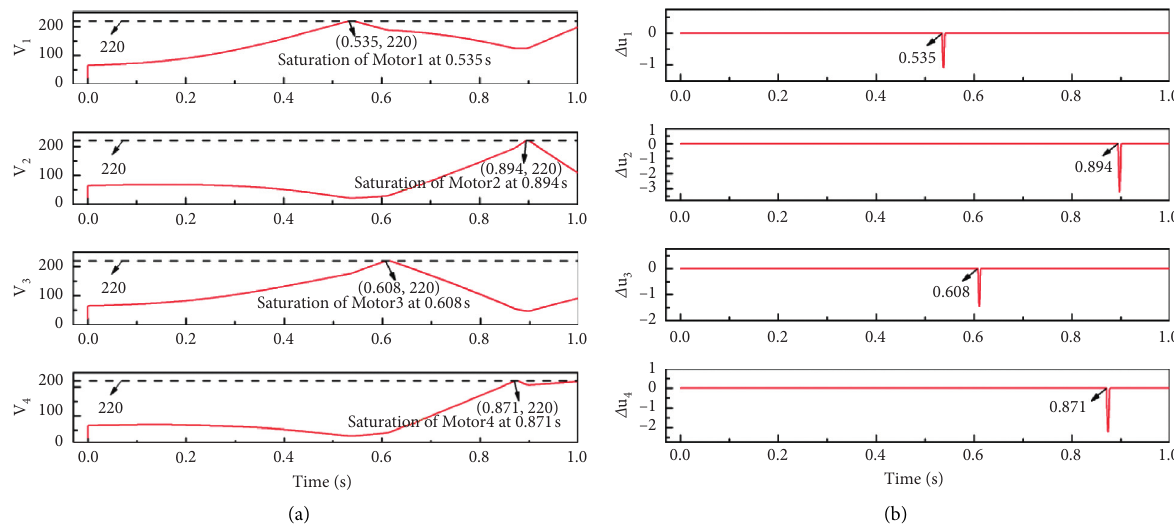
Figure 6: Input curve of the TACTC with AW: (a) the control input curve, (b) the saturated input error curve.